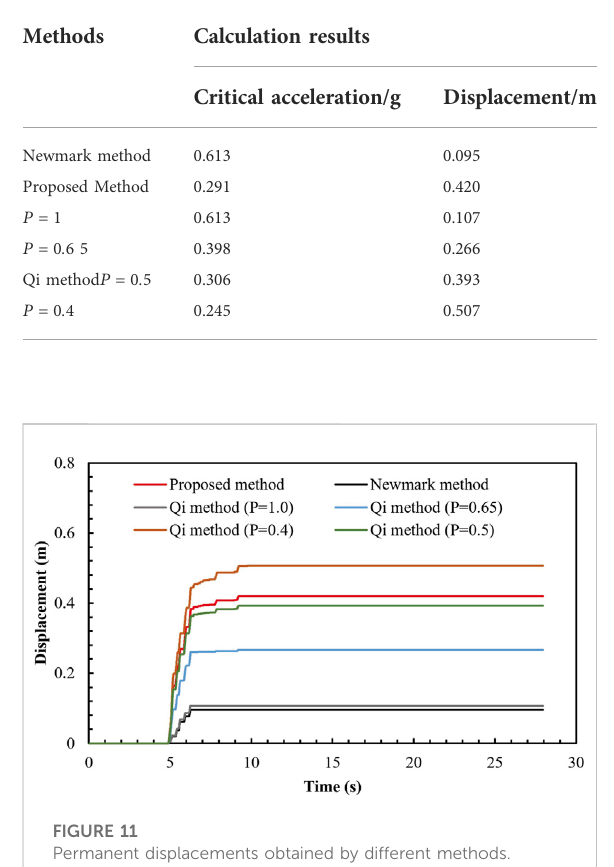
TABLE 2 Calculation results using different methods.